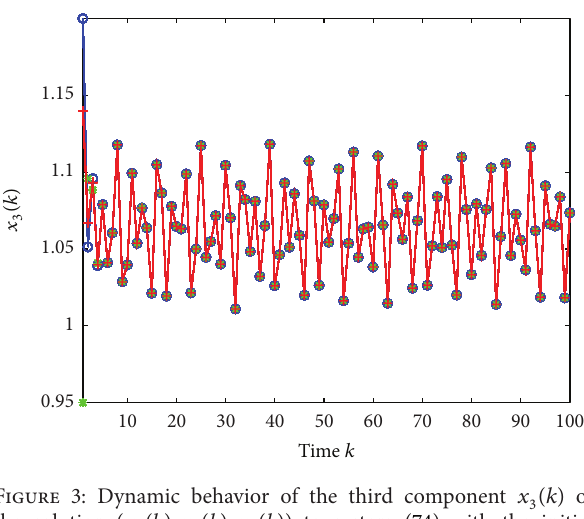
Figure 3: Dynamic behavior of the third component 𝑥 3 (𝑘) of the solution (𝑥 1 (𝑘),𝑥 2 (𝑘),𝑥 3 (𝑘)) to system (74) with the initial conditions (1.13, 1.17, 1.2) , (1.24, 0.96, 0.95) , and (1.2, 1.08, 1.14) for 𝑘 ∈ [1,100] ,